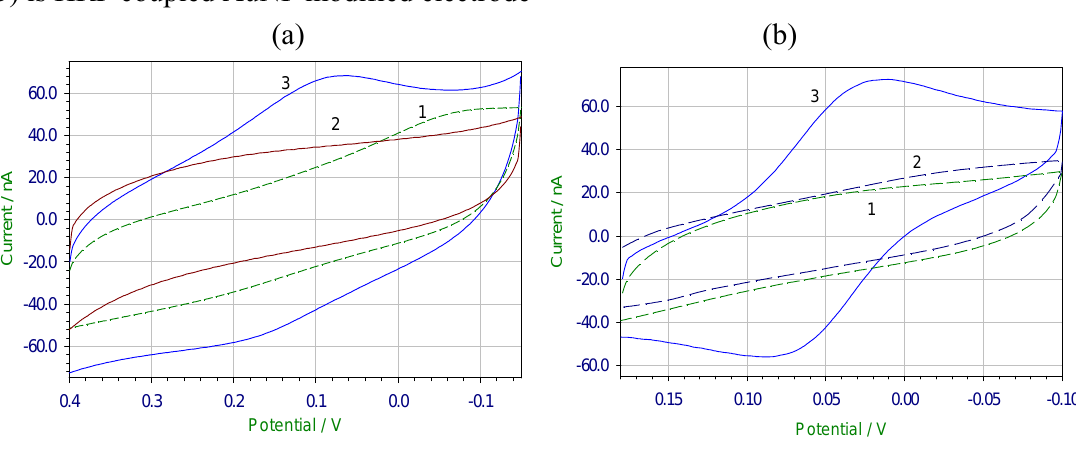
Figure 5. Cyclic voltammogram of HRP coupled to (a) glutathione capped AuNP, (b) lipoic acid capped AuNP. Using gold electrode, 10.2 μ M H Ag/AgCl reference electrode. Plot (1) is blank electrode, (2) AuNP modified electrode and (3) is HRP coupled AuNP modified electrode